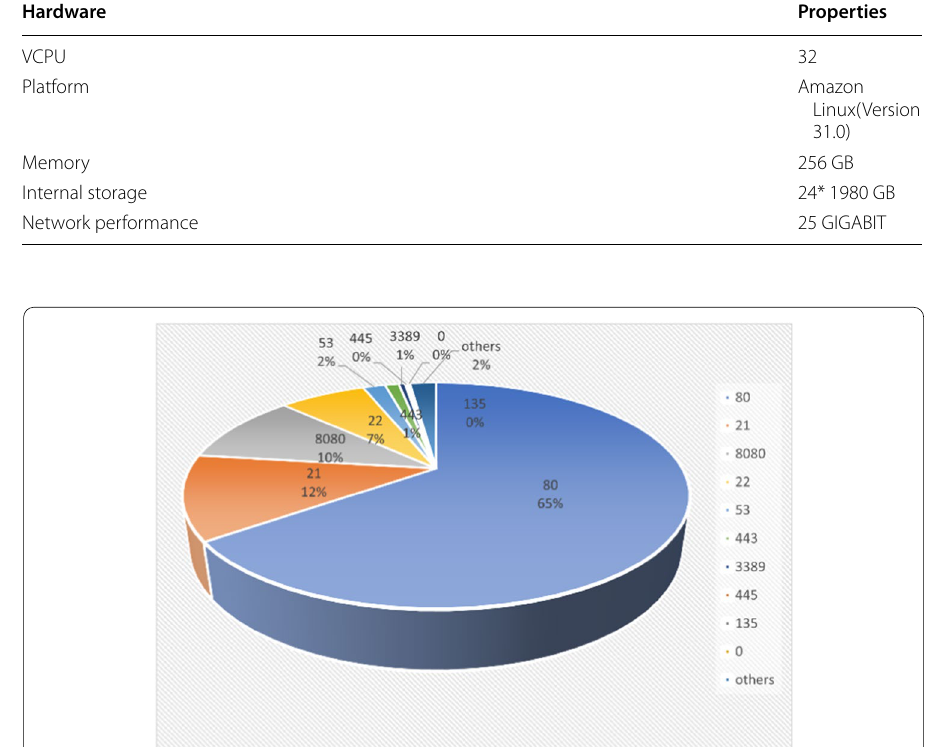
Fig. 2 Ports used during various